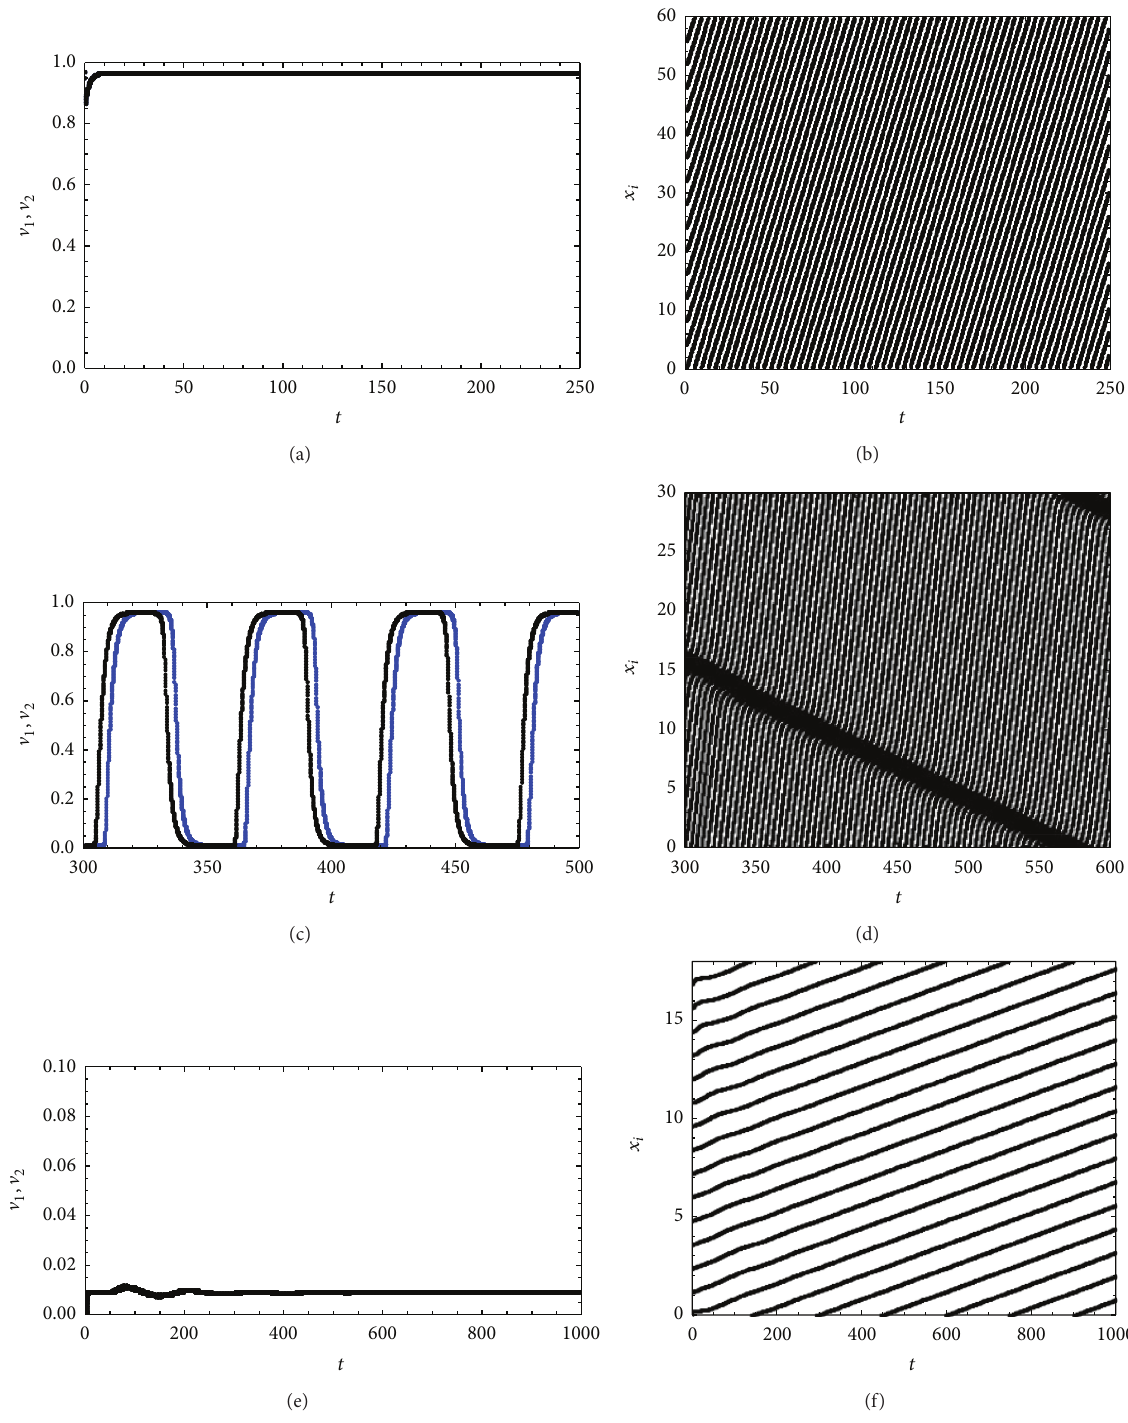
Figure 3: Plot of the velocity and the location of vehicles against time in different regions. We consider the speeds of the first two cars and the location of fifteen cars. The blue curve represents the speed of the first car and the black curve represents the speed of the second car. (a) and (b): region III, 𝜏 = 0.2 , 𝛼 = 0.5 , ℎ ∗ = 4 , V = 0.97 . (c) and (d): region II, 𝜏 = 0.2 , 𝛼 = 0.5 , ℎ ∗ = 2 , V = 0.5 . (e) and (f): region I, 𝜏 = 0.2 , 𝛼 = 0.5 , ℎ ∗ = 1.2 , V = 0.008